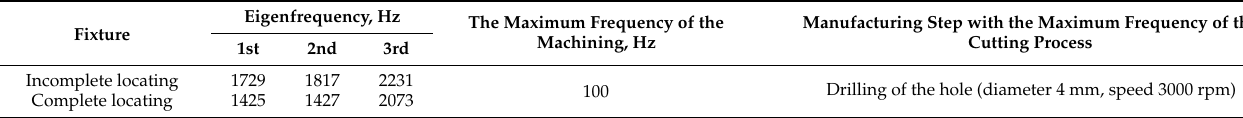
Table 4. The results of fixture eigenfrequencies investigation.